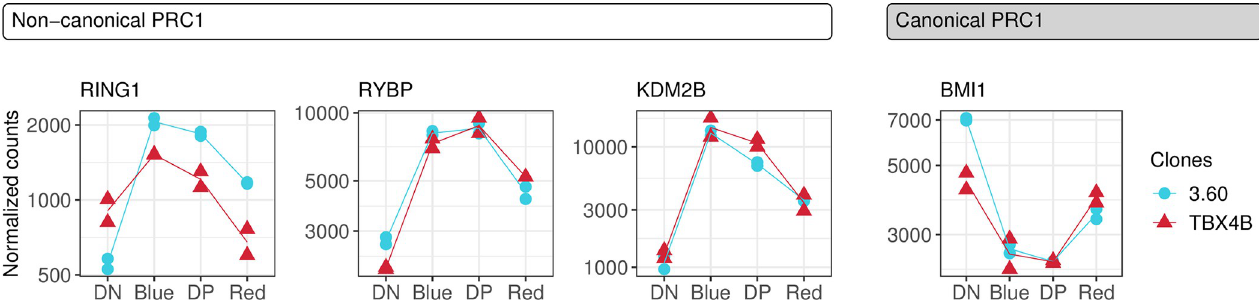
Fig 7. Up-regulation of ncPRC1 members. Gene expression trajectories of ncPRC1 and canonical PRC1 complex members. Y-axis: normalized counts on log 10 -scale. Statistical significance was determined by LRT. FDR-corrected p-value < 0.01.